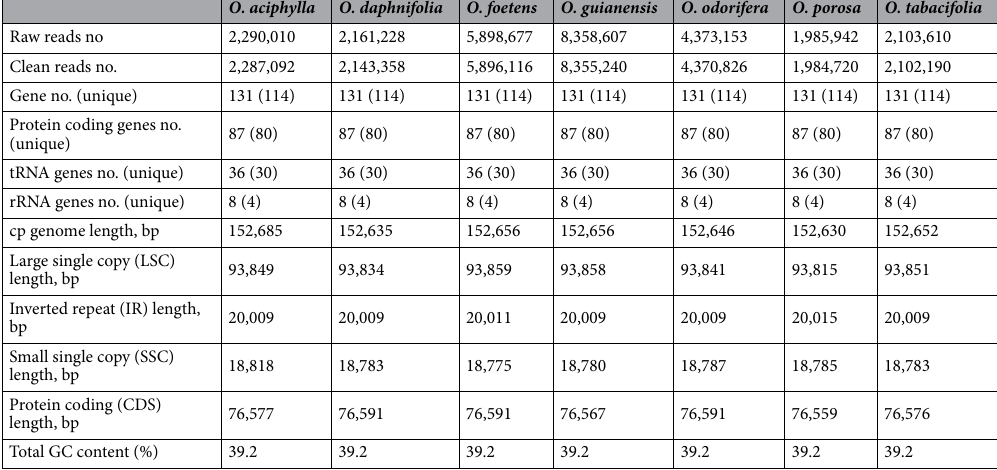
Table 1. Summary of seven complete plastomes of Ocotea